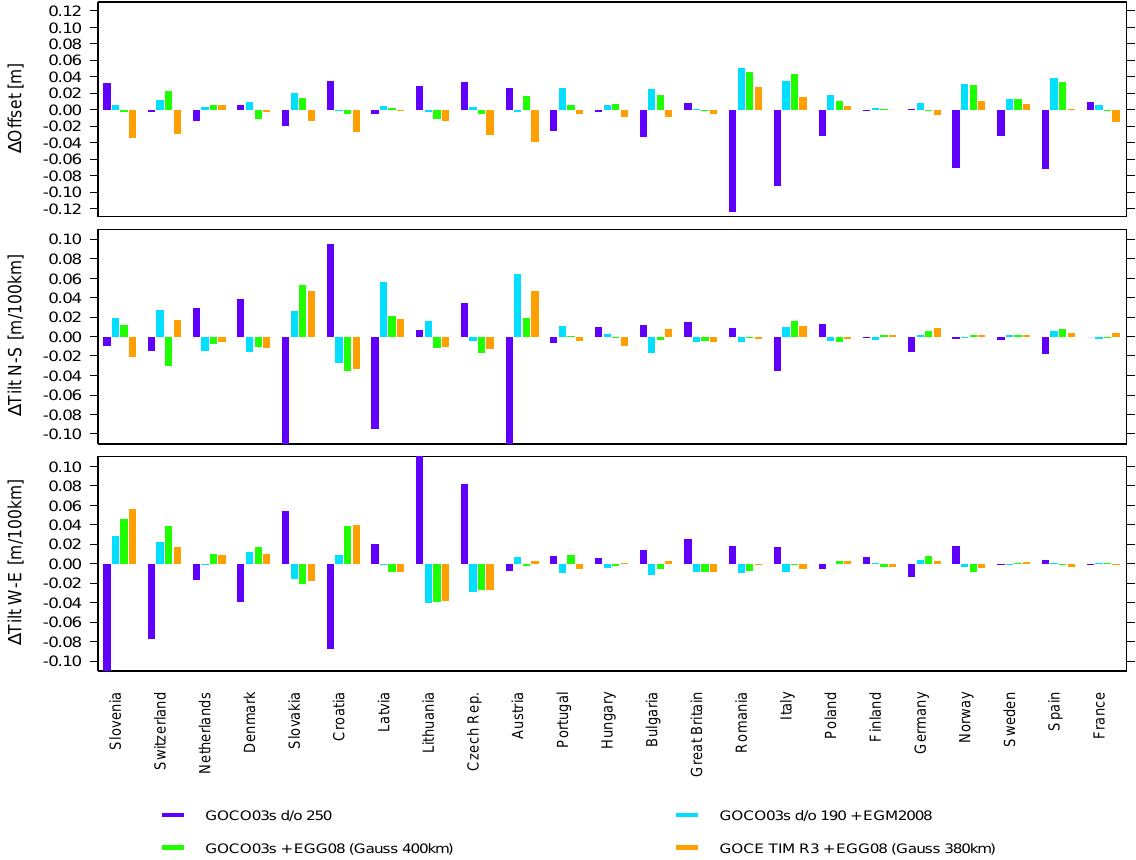
Figure 3. Comparison of estimated height system offsets and slopes based on different gravity field models. The countries are ordered by its ascending area. For each country an individual mean value has been subtracted.